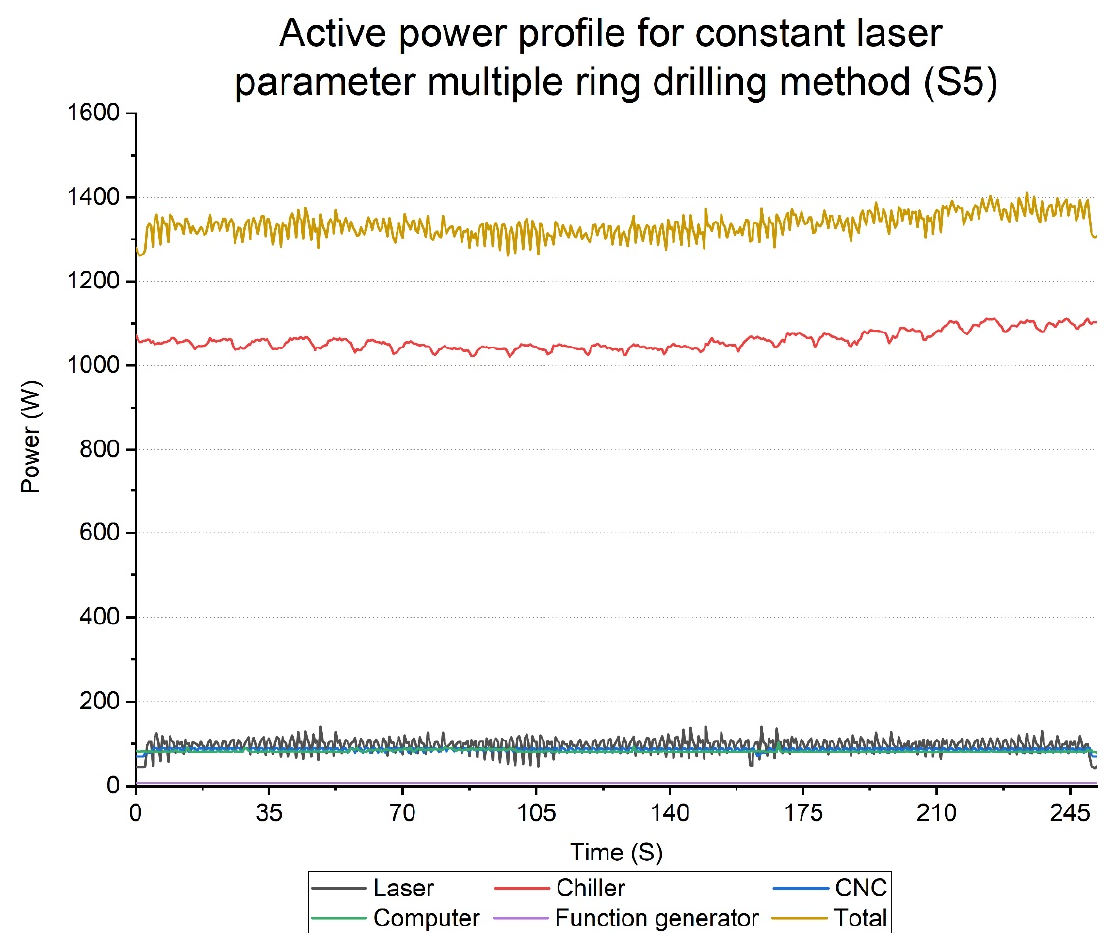
Figure 13. Illustration of total active power profile and sub-device power profile for Constant laser parameter multiple-ring drilling method.